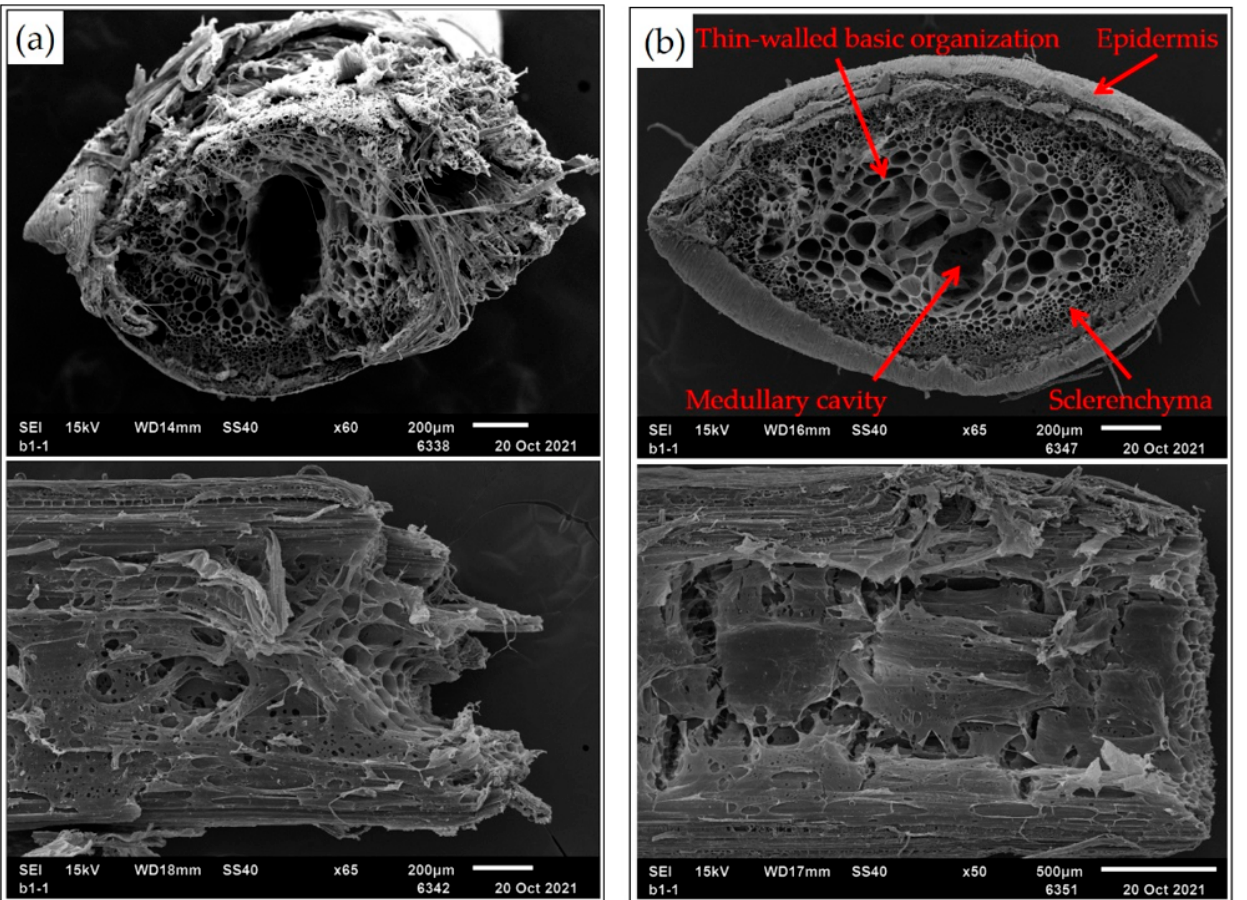
Figure 6. Comparison of micro morphology of Alfalfa incision after 32 h cutting with different blades: ( a ) incision formed by commercial blades; ( b ) incision formed by carbon-nitron-boronized blades.